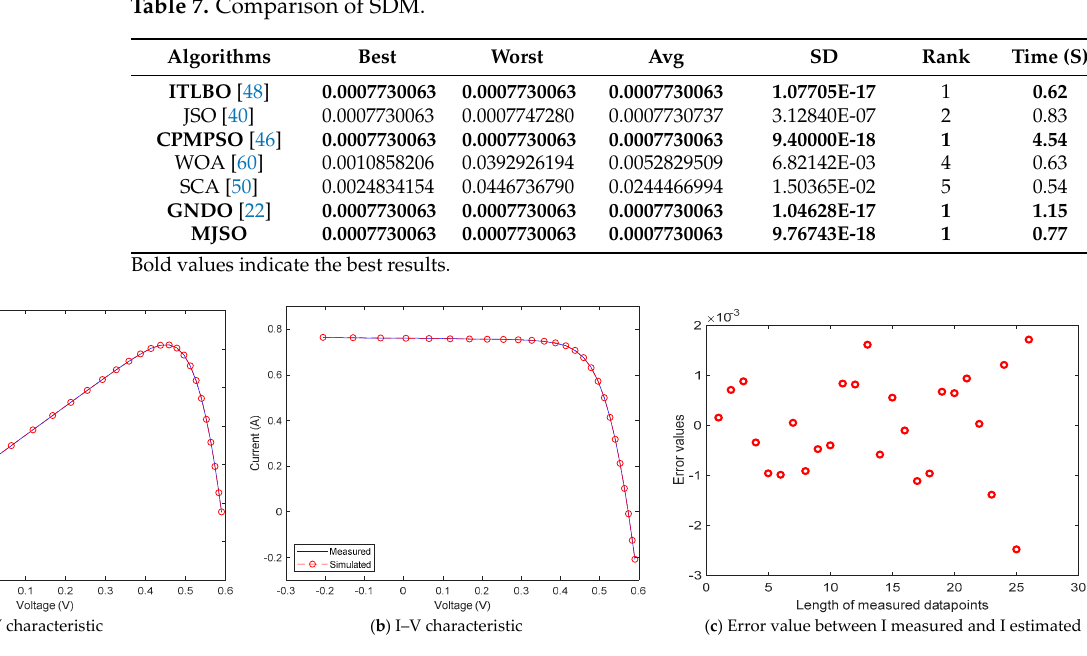
Figure 7. Comparison between the measured and estimated data extracted using MJSO on SDM for R.T.C France.